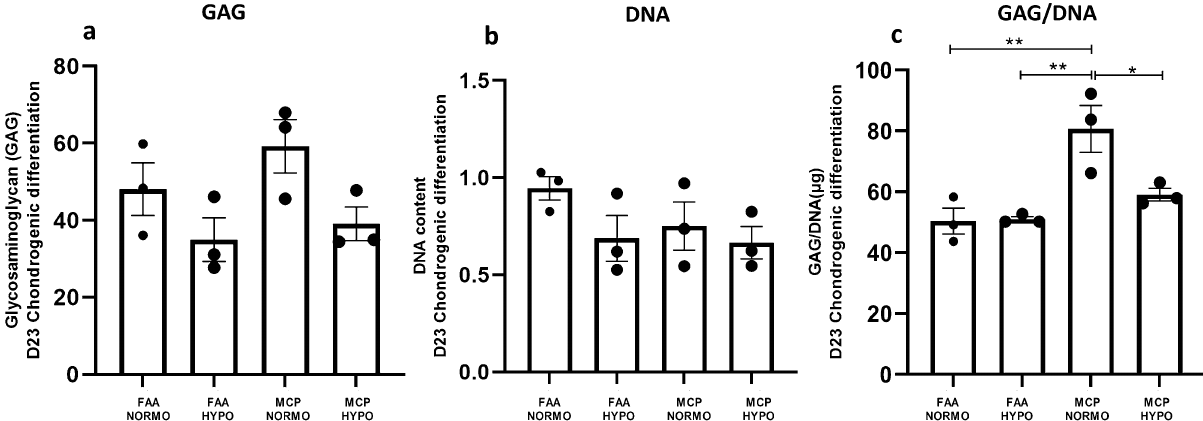
Figure 7. ( a ) Estimation of GAG, ( b ) DNA and ( c ) total GAG/DNA content in the chondrogenic differentiated pellet was performed following papain digestion and quantified using the dimethyl methylene blue dye method. One way-ANNOVA for GAG: 0.084, DNA: 0.25 and GAG/DNA: 0.0047. MCP-Normoxia demonstrated significantly higher levels of GAG/DNA when compared to normoxia FAA-CP ( P = 0.001), hypoxia FAA-CP ( P = 0.002), and hypoxia MCP ( P = 0.01). All values are expressed as Mean ± standard error mean (* P < 0.05, ** P < 0.01), from three biological samples (n = 3). GAG: